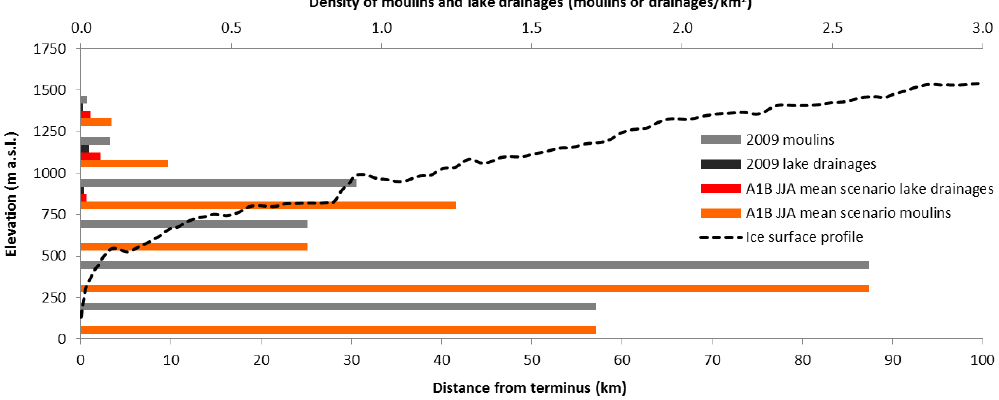
Figure 7. Density of moulins and lake drainages for A1B mean June, July and August Arctic scenario within 250m ice surface elevation